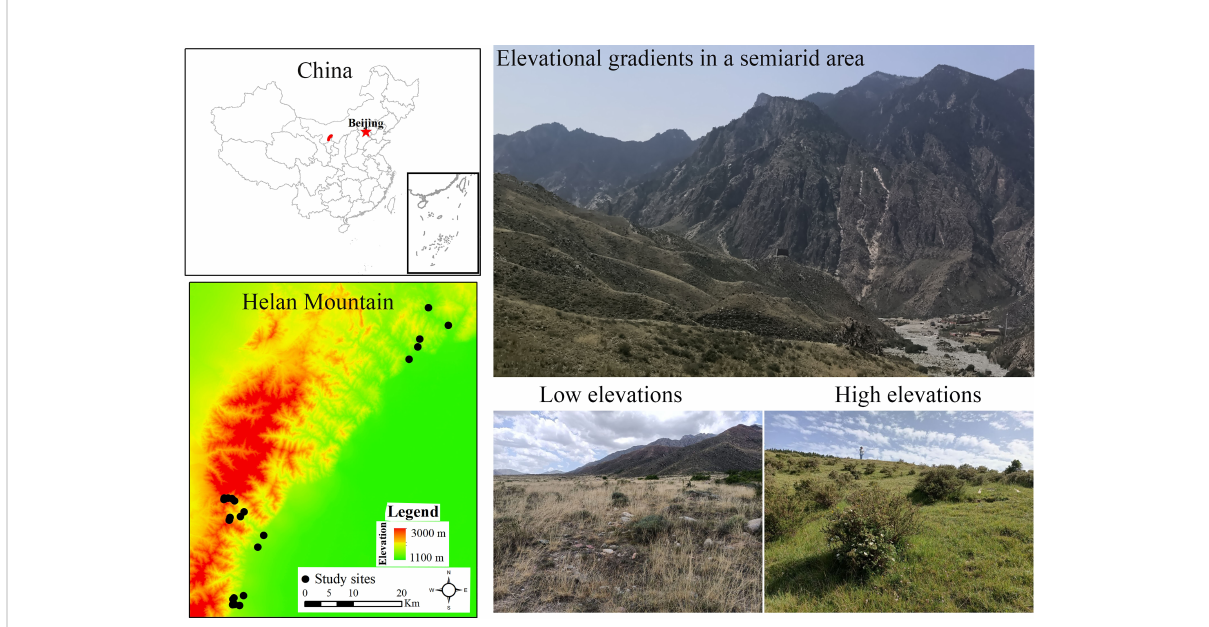
FIGURE 1 Map of the study site and plots on Helan Mountain of arid and semi-arid regions in Northwest